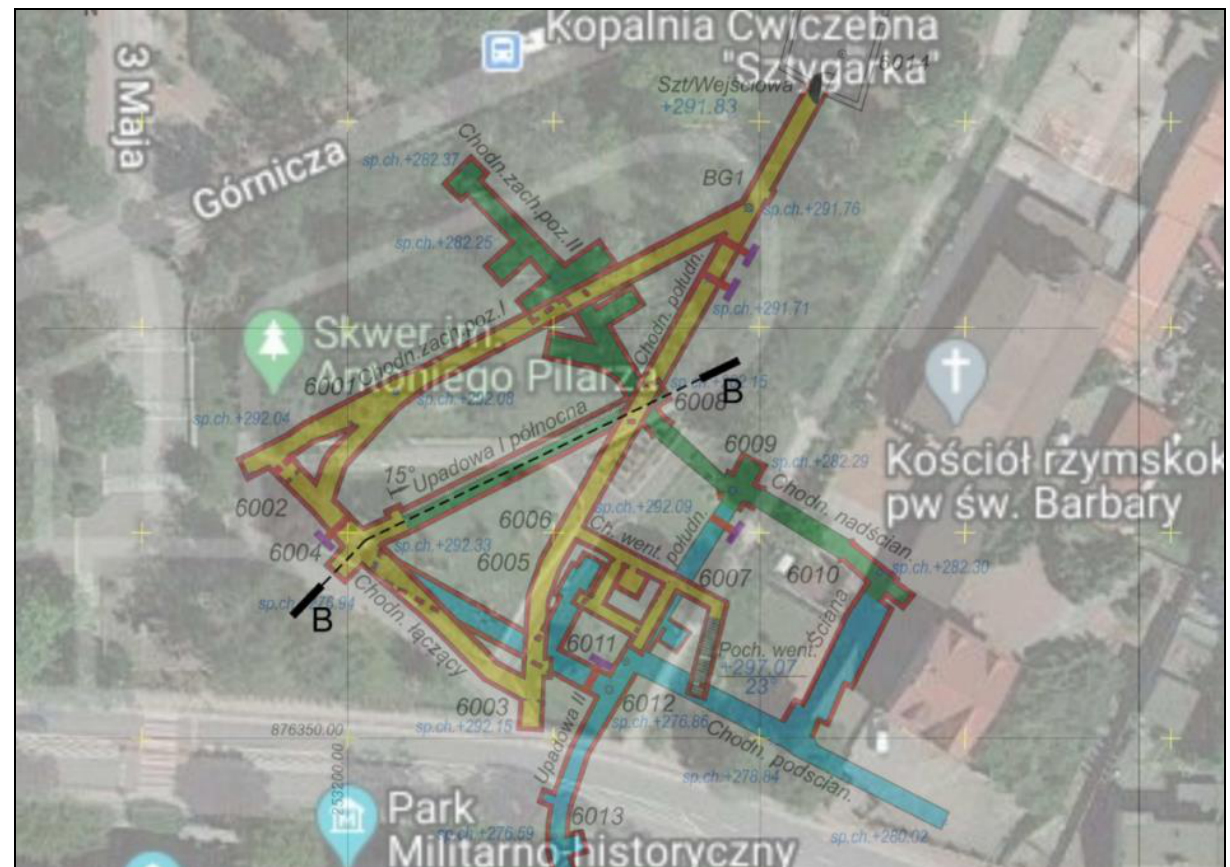
Figure 2. The location of the studied area with marked underground excavations.